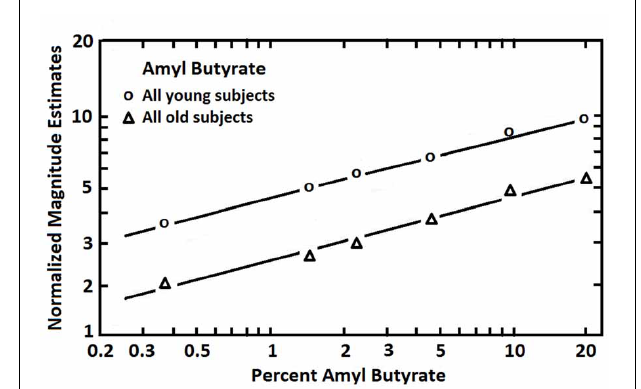
FIGURE 7 | Magnitude estimates given to six concentrations of amyl butyrate after adjustment for number usage by the employment of a cross-modal matching procedure. Each age group was comprised of 10 men and 10 women. The younger group ranged in age from 18 to 25 years, and the older group from 65 to 85 years. From Stevens et al. (1982), with permission. Copyright©1982, ANKHO International,